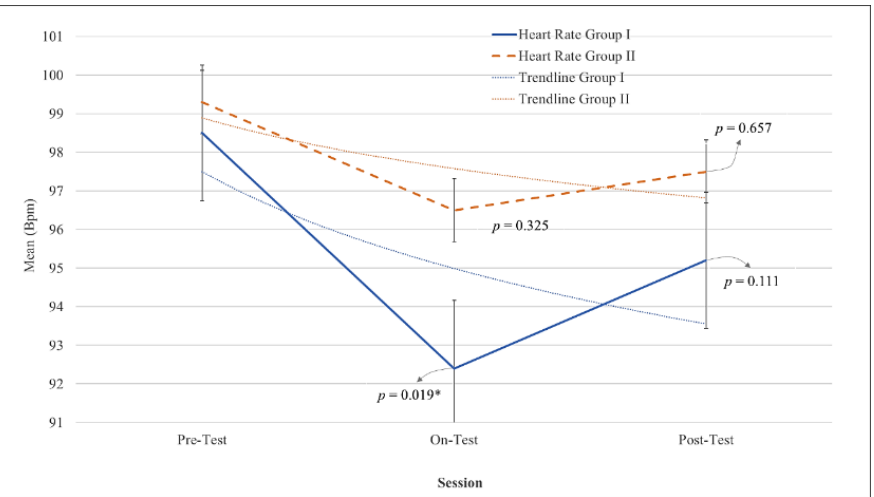
Figure 1. The alterations of heart rate in group I and group II in pre, on, and post-test sessions. Data with * indicated the statistical difference in comparison to the previous session.